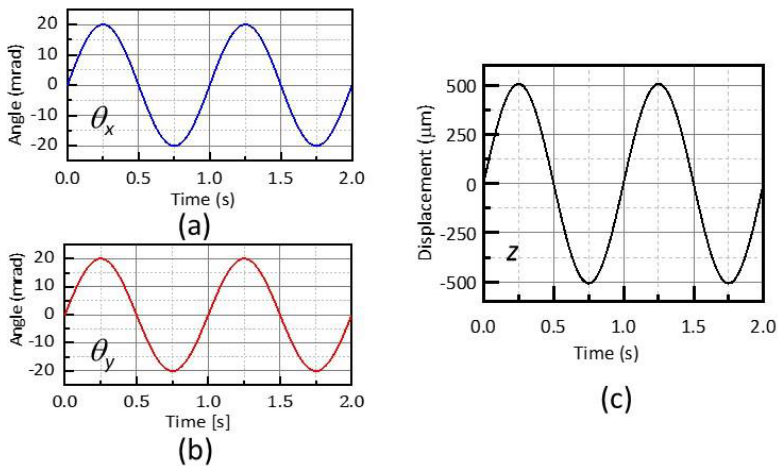
Figure 11. Long stroke positioning of the FSM with the magnetic suspension: ( a ) Inclination in the θ x direction; ( b ) inclination in the θ y ; ( c ) displacement in the Z direction.